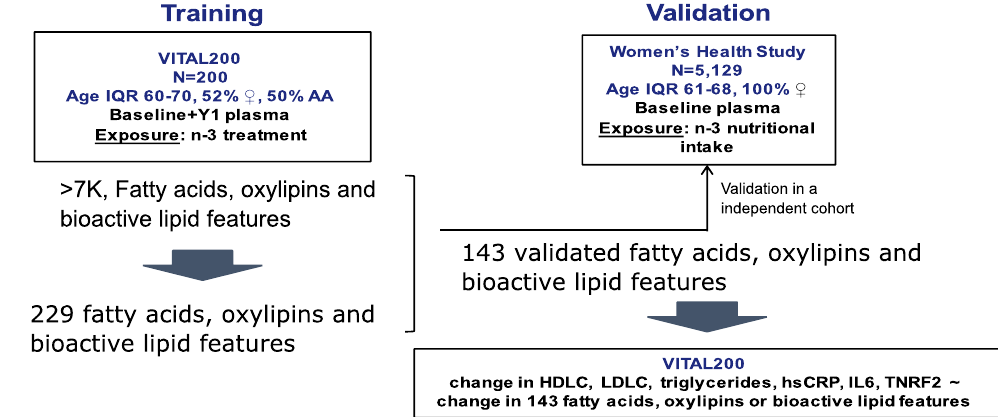
Figure A2. Discovery in the VITAL200 and validation in t he Women’s Health Study (WHS).